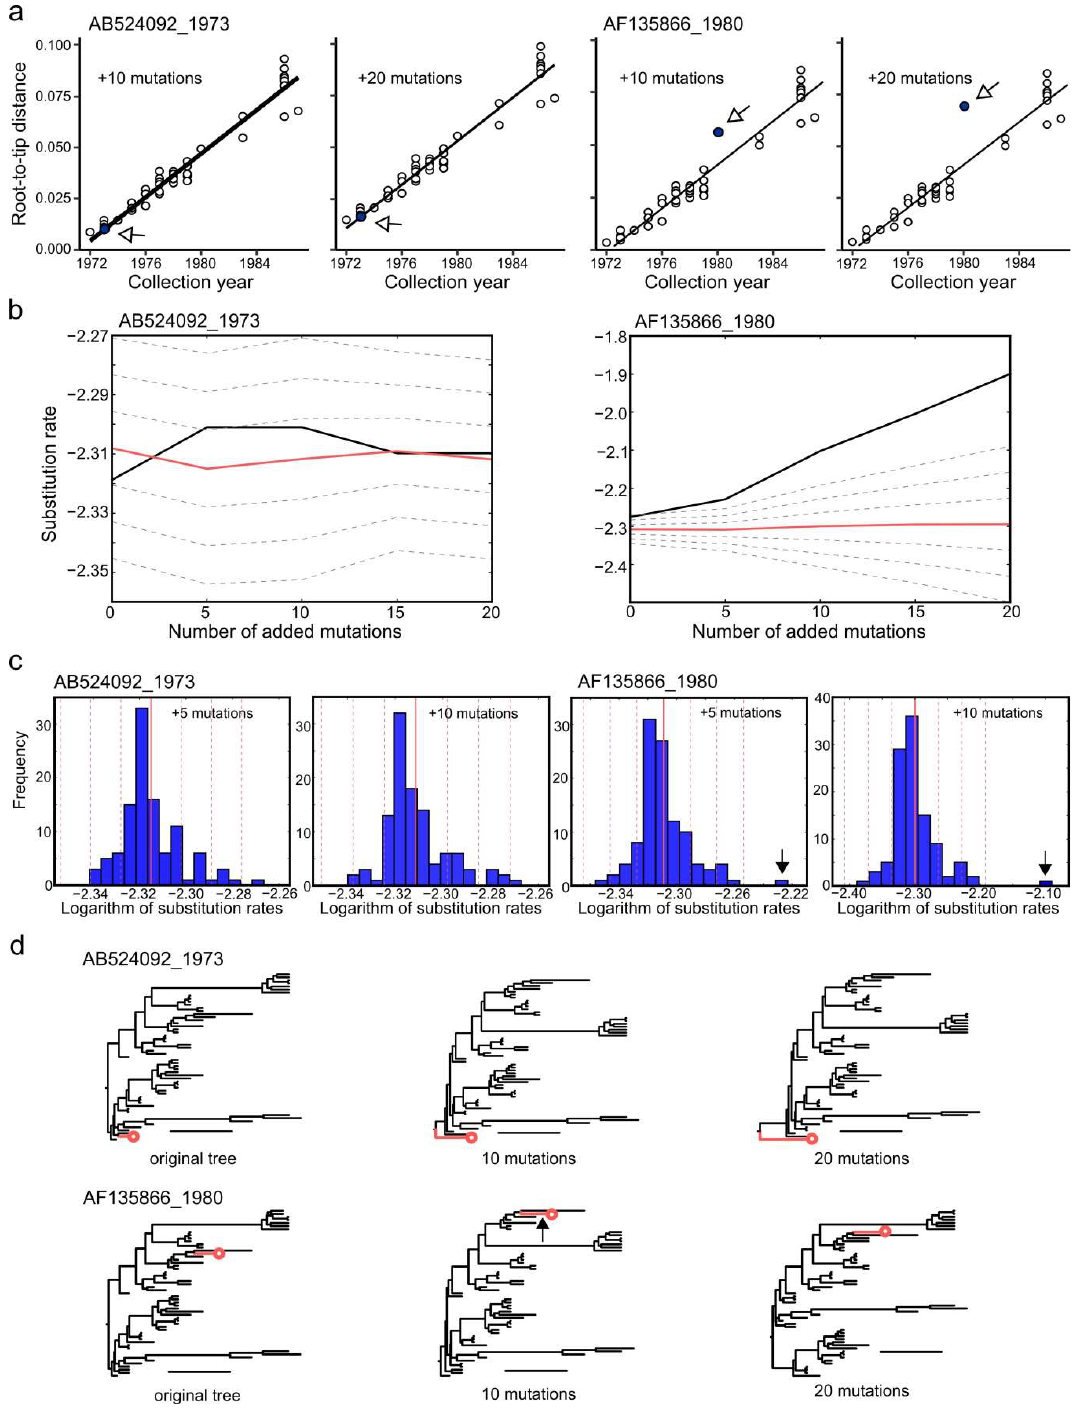
Figure 6. ( a ) The analysis of genotype B1 temporal structure using TempEst software after introducing 10 and 20 random mutations into sequences AB524092 and AF135866. Blue dots correspond to the isolates with the erroneous sequences. ( b ) The effect of adding random mutations on the substitution rates inferred in the Bayesian phylogenetic analysis for EV-A71 genotype B1 sequences AB524092 and AF135866. The mean rate in a tree is plotted with a bold red line; the terminal branch rate of the altered sequence is plotted with a black line. Dashed gray lines indicate mean ± 1SD, 2SD, and 3SD of the rates in the inferred trees. ( c ) The frequency distribution of decimal logarithms of substitution rates in genotype B1 trees that included sequences AB524092 and AF135866 after adding five random mutations. Solid and dashed red lines indicate mean rates and mean ± 1SD, 2SD, and 3SD,